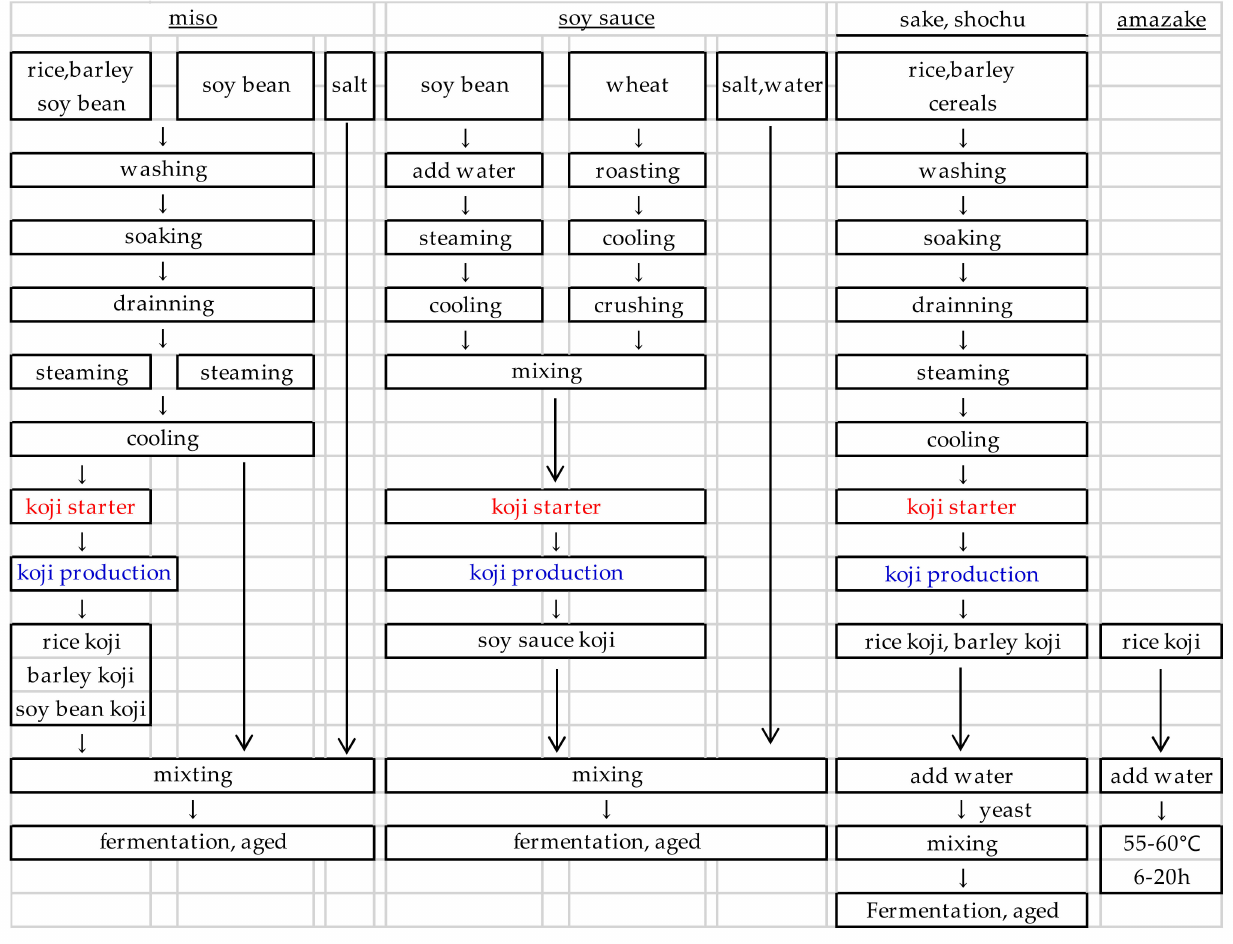
Figure 3. The manufacturing process of fermented